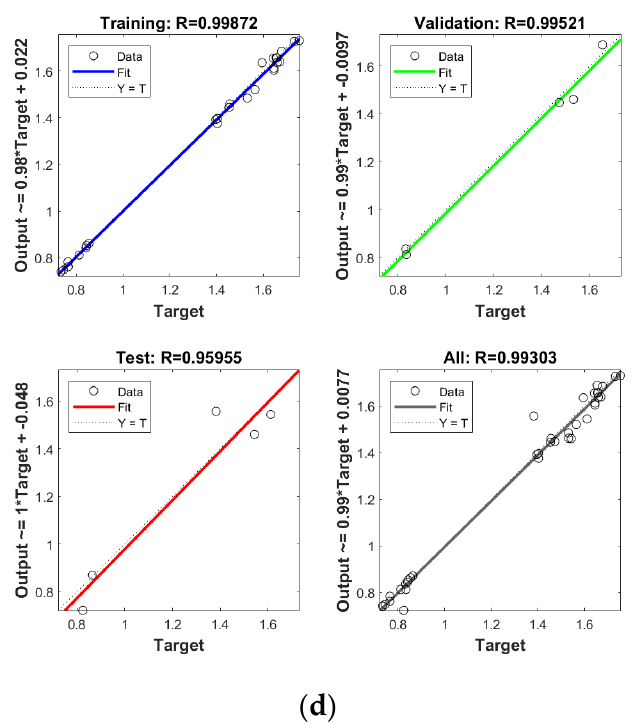
Figure 4. Establishment of prediction model by ANN for free radical of thermal oxidized PO ( a ), RO ( b ), SO ( c ) and LO ( d ). Table 4. Prediction performance of different models for free radicals in different vegetable oils.